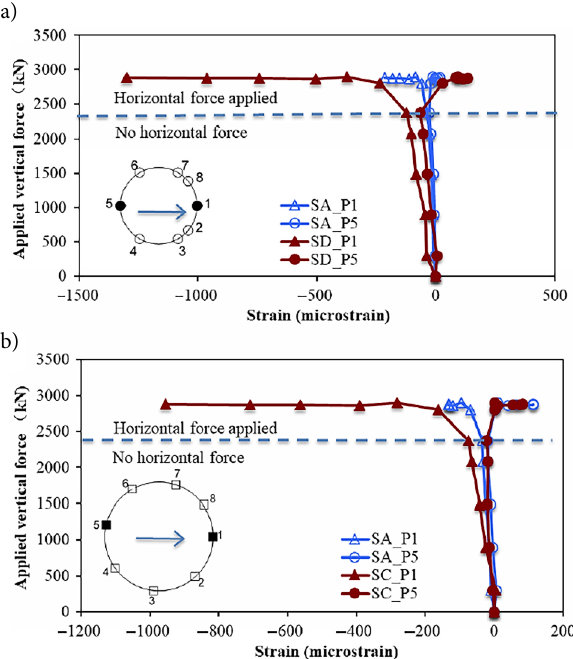
Figure 7. Normal strain in the column and column-foundation connection for Type A in Stage 2: a – During the processes of vertical force applied; b – During the processes of horizontal force